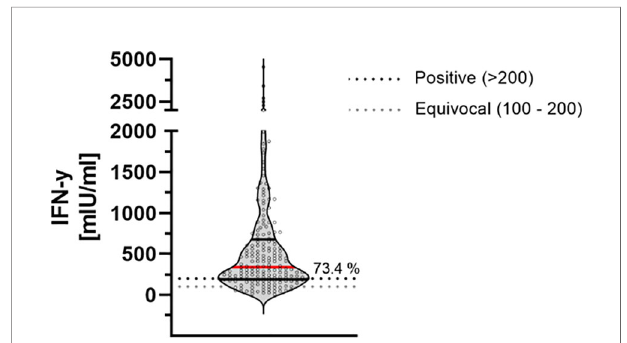
FIGURE 2 | Quantitative determination of anti-SARS-CoV-2-IgG antibodies 9 months after second dose of BNT162b2 (n = 184). Anti-SARS-CoV-2-IgG antibodies were determined using a quantitative assay from Abbott. In keeping with the WHO-standard, data were expressed in Binding Antibody Units per ml (BAU/ml). Samples were marked seronegative below 7.1 BAU/ml whereas values above 7.1 BAU/ml were determined to be positive (horizontal black dotted line), as mentioned by the manufacturer. Red line marks the mean. The dashed gray line marks the positive cutoff speci fi ed by the manufacturer.